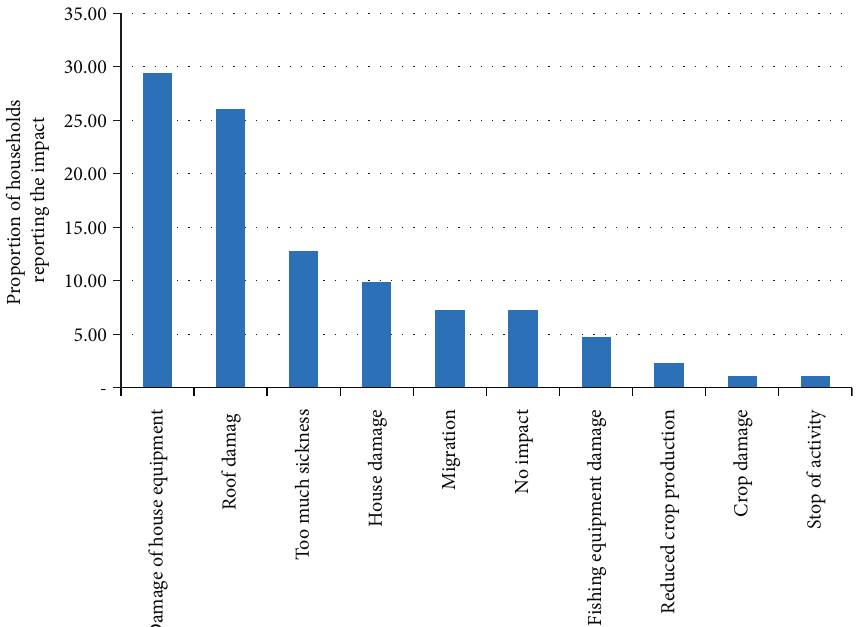
Figure 8: Impact of climate-related stressors as perceived by local people.